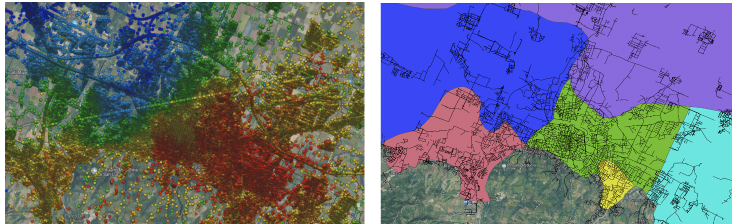
Figure A3. The left panel shows the five clusters retrieved by the PSI analysis corresponding to very high subsidence (blue), subsidence (light blue), natural subsidence (green), stable (orange), stable/uplifting (red). The right panel shows the geological map of the Bologna-Modena region divided in alluvial plain (purple), northern and southern Reno-Lavino alluvial conoids (blue and red, respectively) and northern and southern conoids (green and light red,